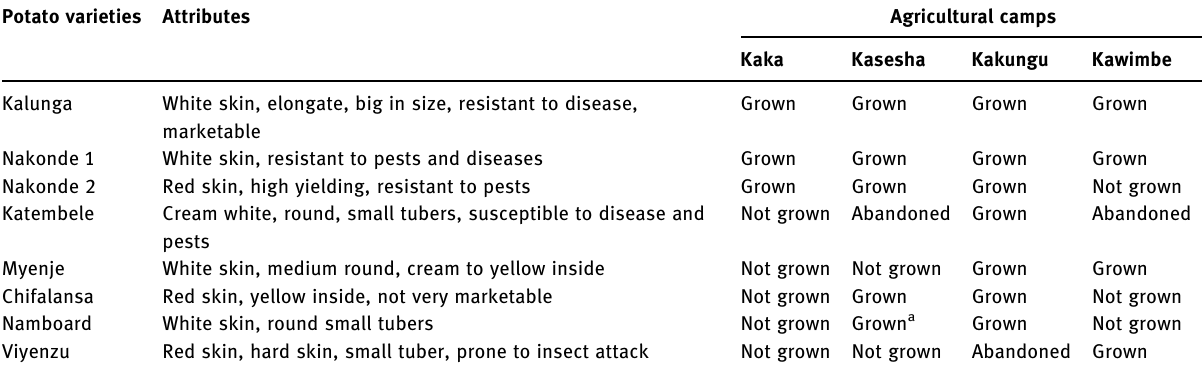
Table 3: Potato varieties grown and those abandoned as reported by the farmers during the focus group discussion in August 2018 Survey, Mbala Potato varieties Attributes